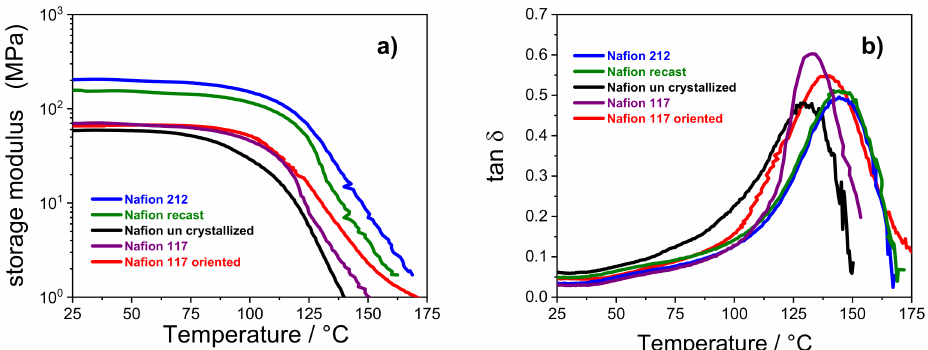
Figure 4. Storage modulus ( a ) and tan δ ( b ) versus temperature of PFSA